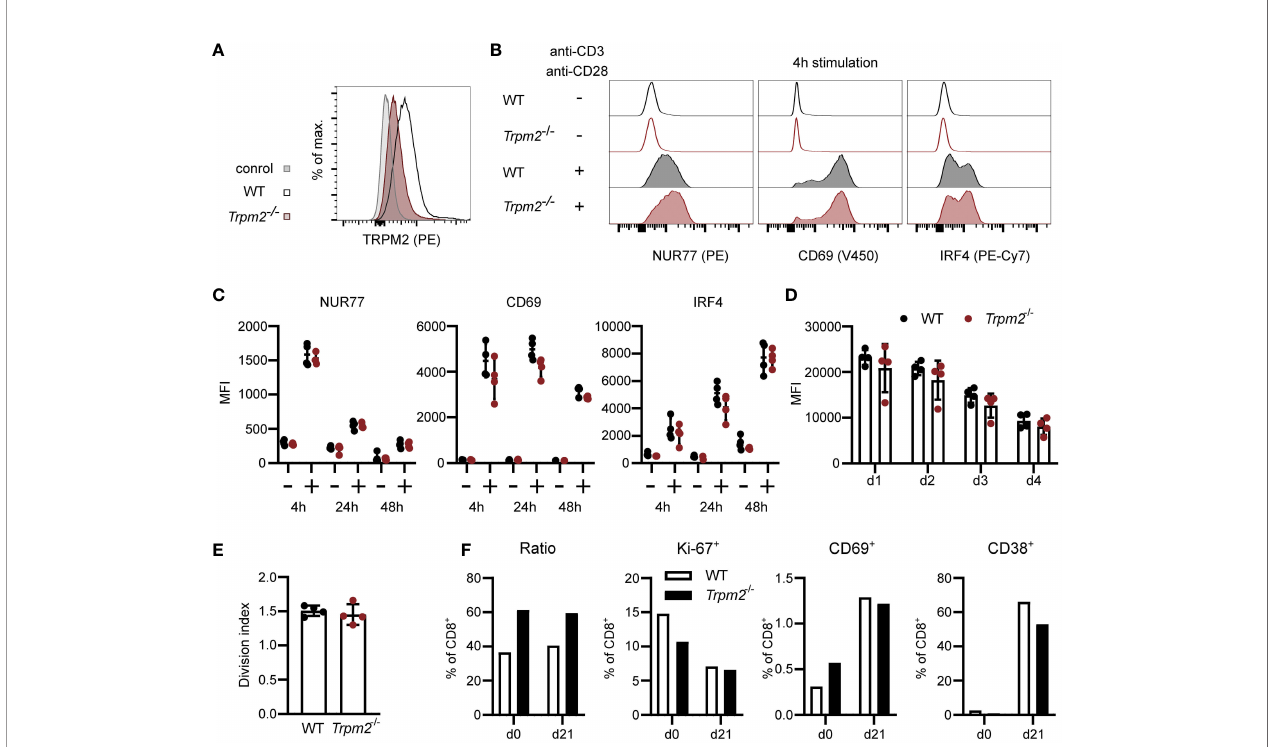
FIGURE 1 | TRPM2 de fi ciency does not impair CD8 + T-cell activation in vitro . (A) CD8 + T cells were intracellularly stained with anti-TRPM2 mAb and PE-conjugated anti-rat IgG antibody (control: WT cells stained only with the secondary antibody). (B, C) Spleen cells from WT and Trpm2 -/- mice were stimulated for 4, 24, or 48 h with plate-coated anti-CD3 ϵ mAb and soluble anti-CD28 mAb. Expressions of CD69, NUR77, and IRF4 were determined by extra- and intracellular antibody staining. Representative staining (B) and results (C) for CD8 + T cells are shown. (D, E) Spleen cells were CFSE-labeled and stimulated with anti-CD3 ϵ mAb and anti-CD28 mAb. Representative results for the mean fl uorescence intensity (MFI) of CFSE of CD8 + T cells on days 1 – 4 (D) and the division index for day 4 (E) are given. (F) WT (CD90.1 + ) and Trpm2 -/- (CD90.2 + ) spleen cells were mixed and stimulated with anti-CD3 ϵ and anti-CD28 for 3 days. Then, cells were washed and incubated with IL-7. On day 21, cells were analyzed by extra- and intracellular antibody staining. Representative results for the ratio of CD90.1 + and CD90.2 + CD8 + T cells and for the expression of the proliferation markers Ki-67 and of CD69 and CD38 are shown. Bars and scatters in (C – E) give the mean ± SEM and were analyzed with the unpaired t-test. All experiments were conducted at least